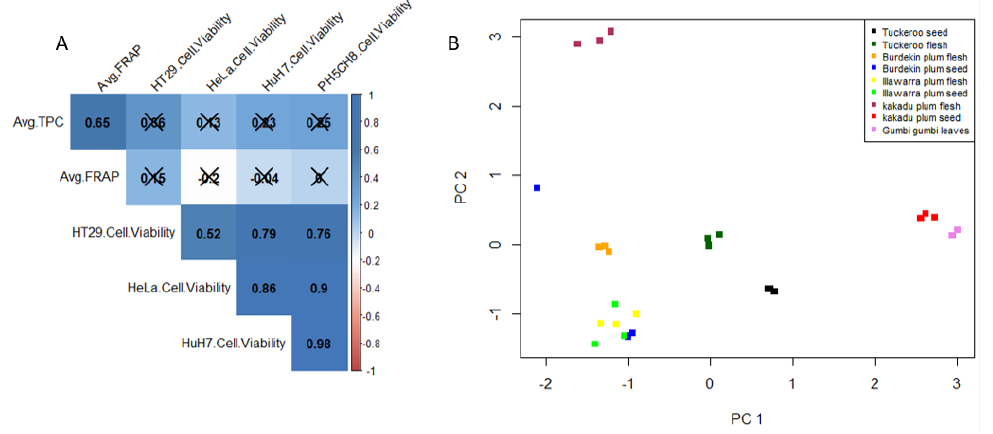
Figure 4. ( A ) Correlation plot; ( B ) PCA scores plot.